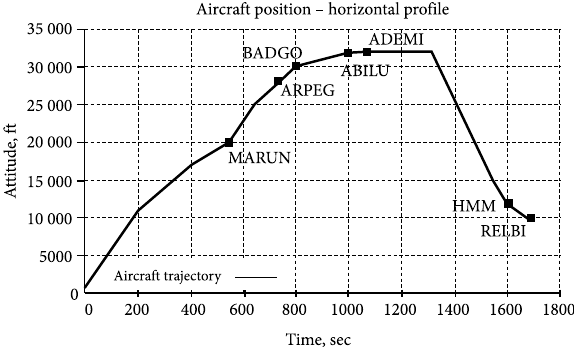
Fig. 6. Vertical plane navigation (Vertical speed control)